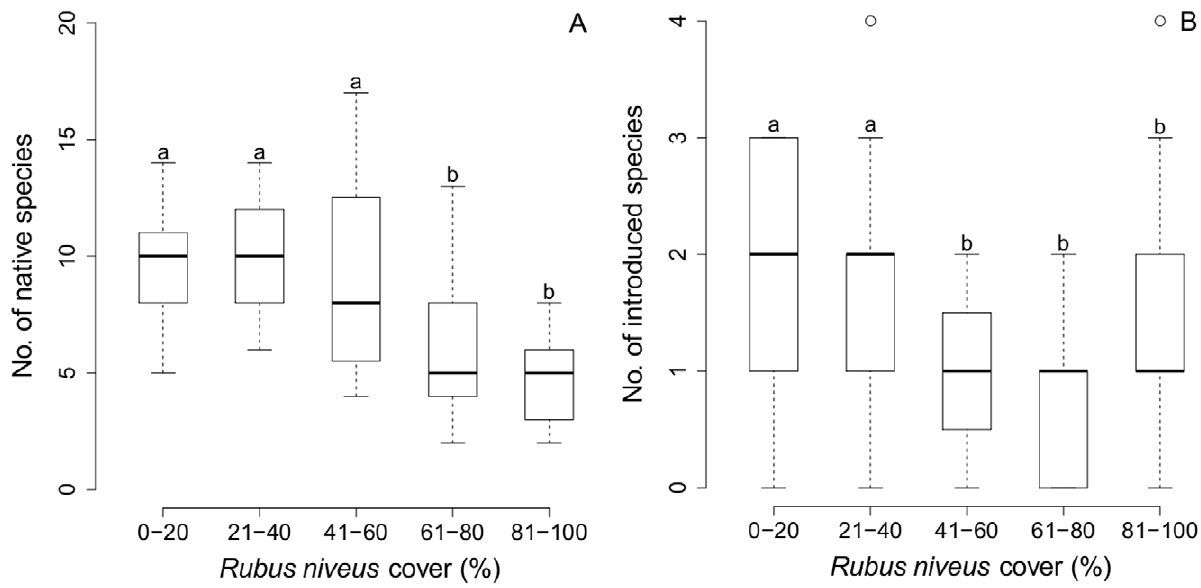
Figure 2. Relationship between R.niveus cover and species richness. Lines within the box represent the median values of the number of species found within each cover category; the bottom and top edges of the box represent 25th and 75th percentiles of all data, respectively; the bottom and top bars represent 5th and 95th percentiles. ANOVA-GLM (quasi-Poisson error distribution); native species: F4,119=20.83, P , 0.001; introduced species: F4,119=4.04, P , 0.001 ( a,b denote group differences detected by statistical analyses amongst R. niveus cover categories).